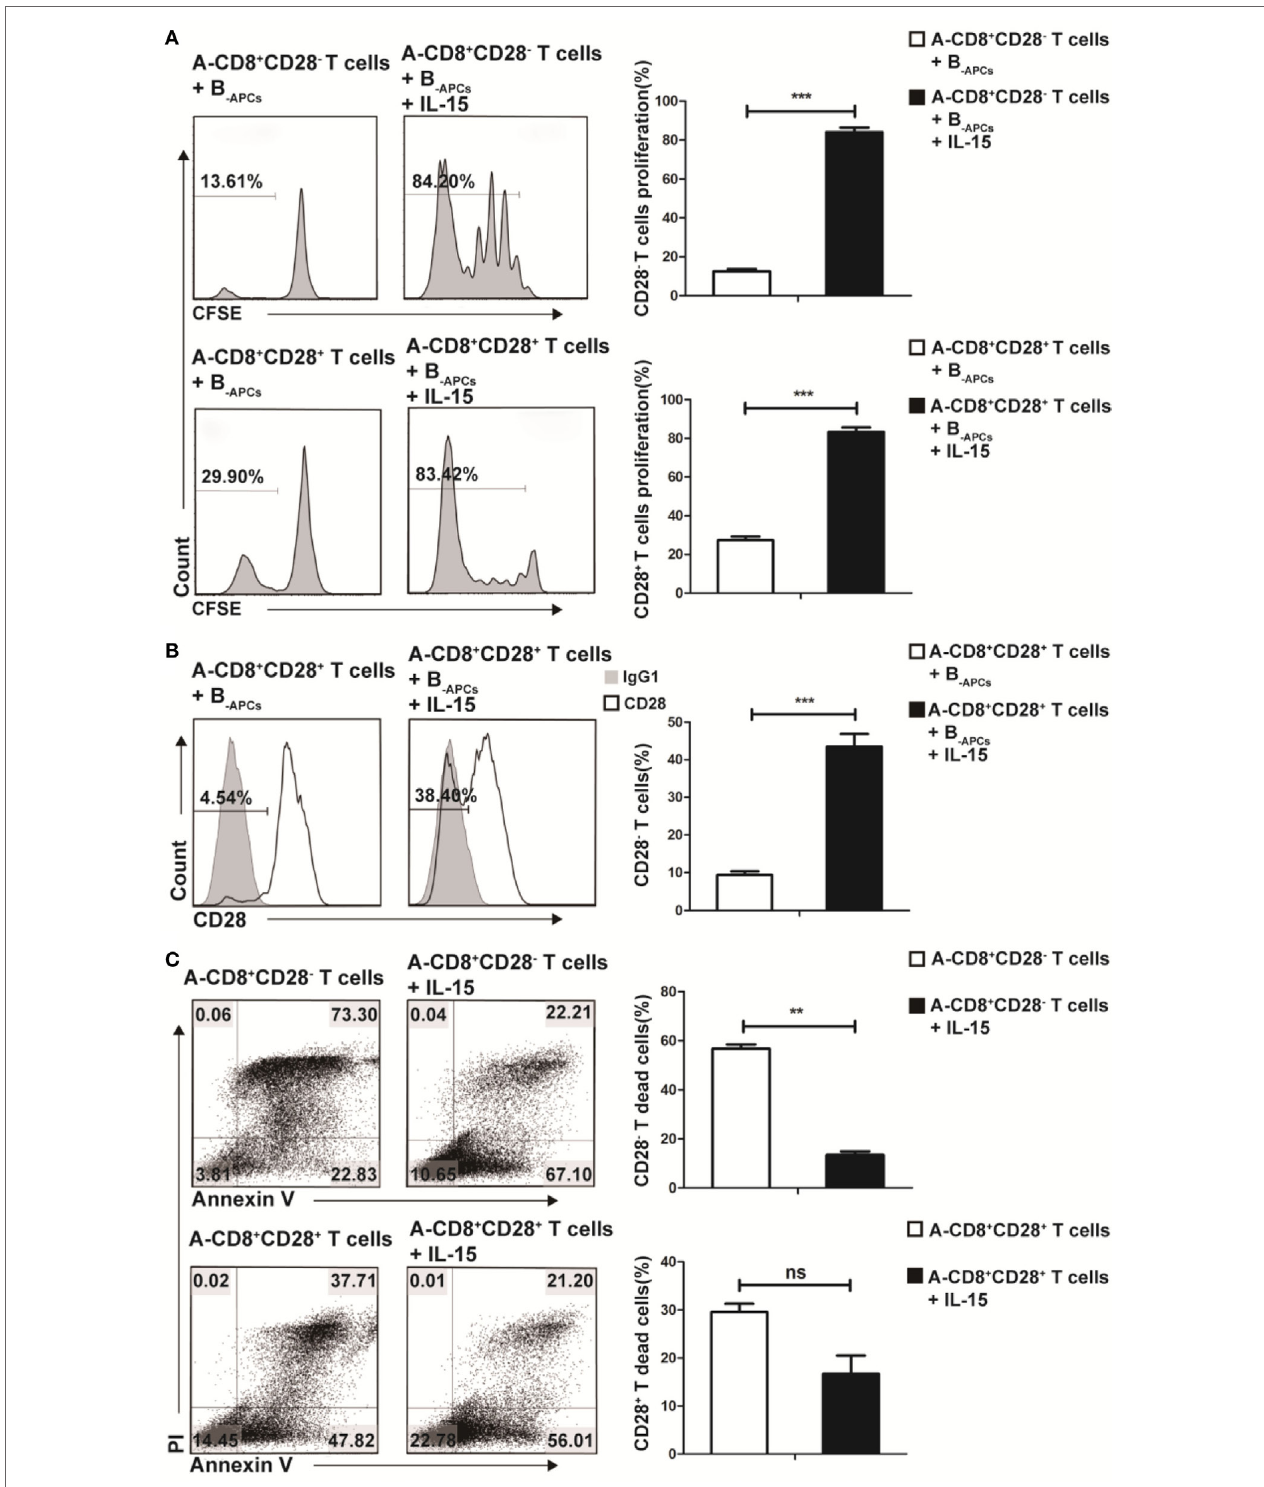
FigUre 2 | IL-15 promotes expansion of CD8 + CD28 − T cells in vitro through different mechanism. Freshly isolated CD8 + CD28 − T cells or CD8 + CD28 + T cells were labeled with carboxyfluorescein diacetate succinimidyl ester and cultured with B -APCs in the presence or absence of IL-15 for 9 days. (a) The percentages of proliferating cells in CD8 + CD28 − or CD8 + CD28 + T cells after culture. (b) The percentages of CD8 + CD28 − T cells number in CD8 + CD28 + T cells after cultured in the presence or absence of IL-15 for 9 days. (c) Apoptosis of CD8 + CD28 + T cells or CD8 + CD28 − T cells when cultured in the presence or absence of IL-15 for 9 days. The bar graphs indicate the means ± SD, n = 3. * p < 0.05, ** p < 0.01, and *** p < 0.001.